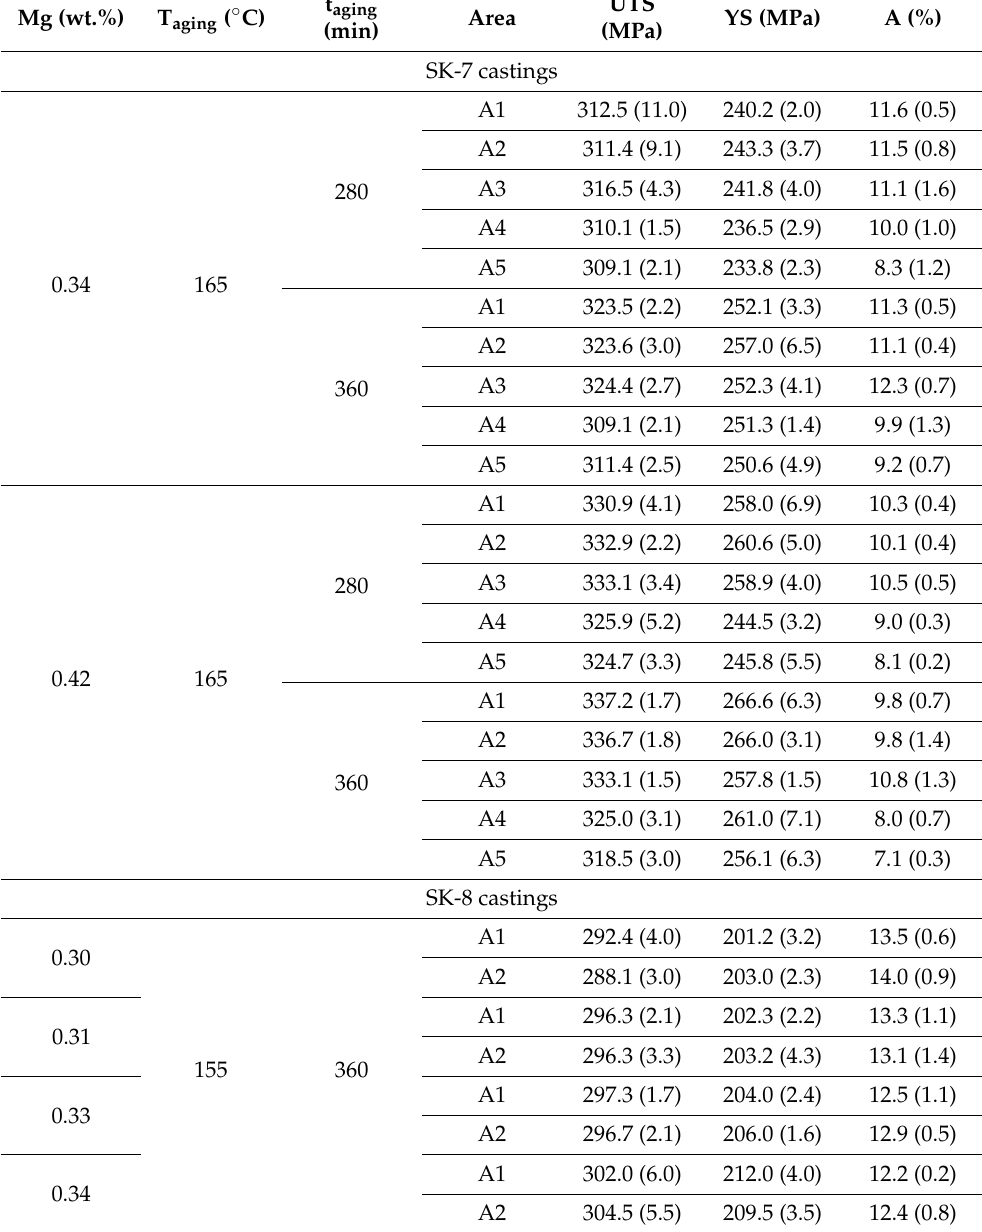
Table 12. Average values of UTS, YS and A for each Mg content and aging temperature and time in castings SK-7 and SK-8 (standard deviation values are shown between